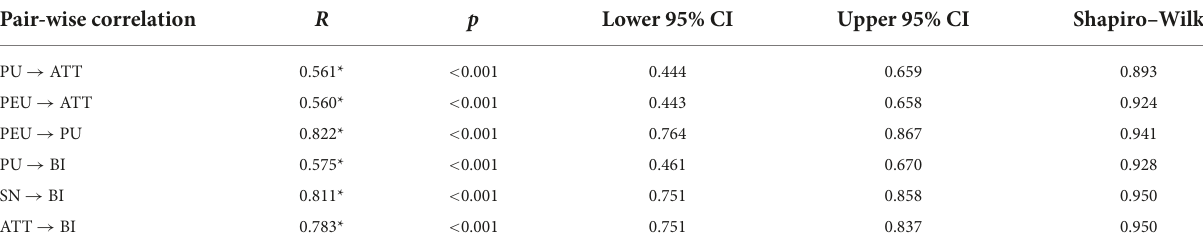
TABLE 1 Pearson’s correlation ( r ) based on the conceptual model influencing students’ behavioral intentions of using smartphone technology in the classroom. Pair-wise correlation R p Lower 95% CI Upper 95% CI Shapiro–Wilk